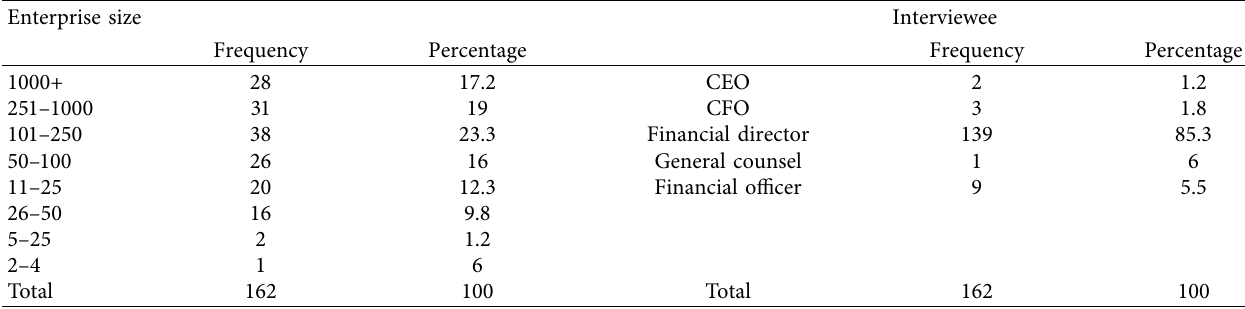
Table 1: Sample description table.